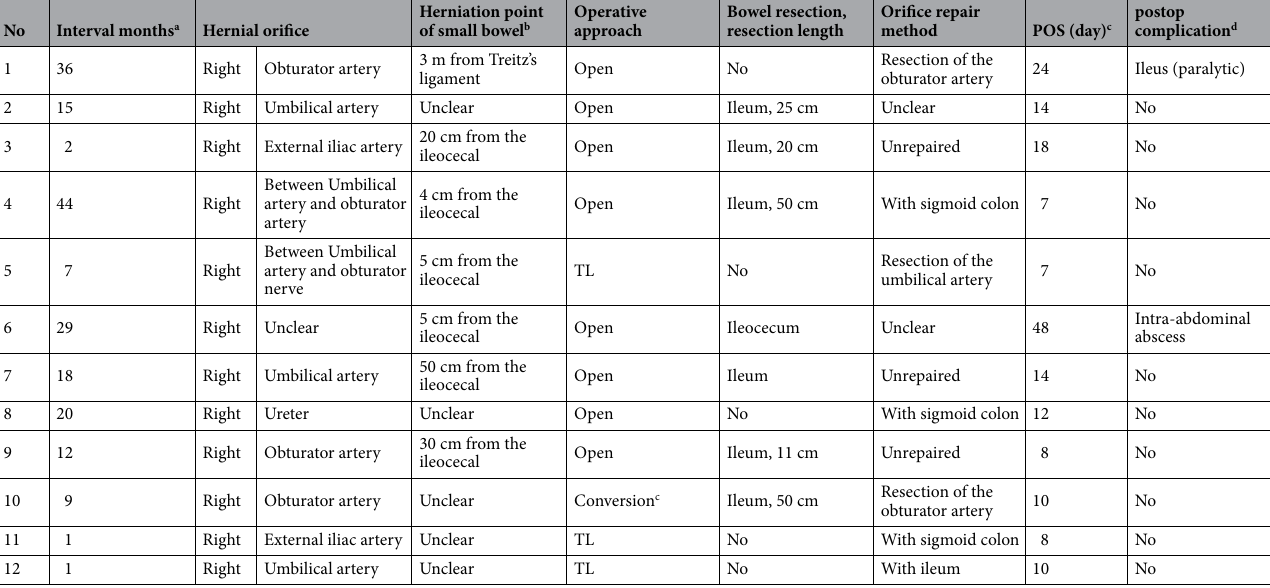
Table 5. The surgical findings at IBSPP repair operation. TL, total laparoscopic surgery. a Interval months between operation and onset of obstruction. b Position of the incarcerated small bowel. c Length of postoperative hospital stay. d The Clavien-Dindo scale was used to evaluate postoperative complications, and IIIa or higher was defined as major complications.